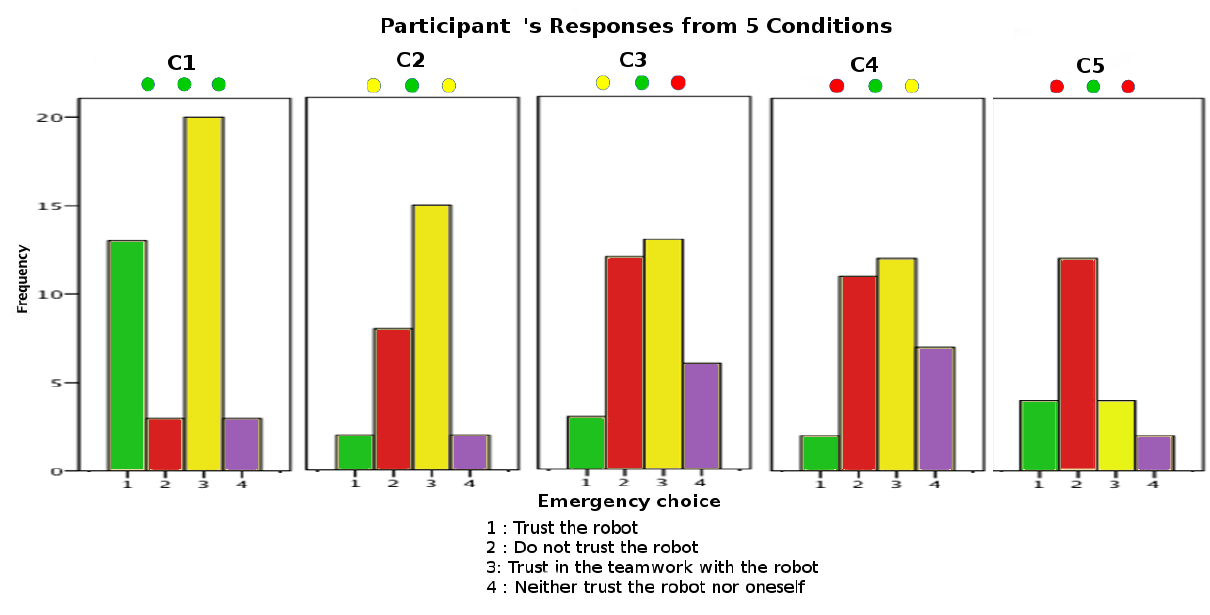
Figure 4: Responses of participants from different conditions to the Emergency Scenario. Each conditions is composed by 3 different sets of tasks: first and third sets are composed respectively by 3 tasks, the second set is composed by 4 tasks. Each dot represents a set of tasks. The set of tasks in green are executed without any error by the robot; the set of tasks in yellow are the ‘small’ errors executed by the robot; and the set of tasks in red are the ‘big’ errors executed by the